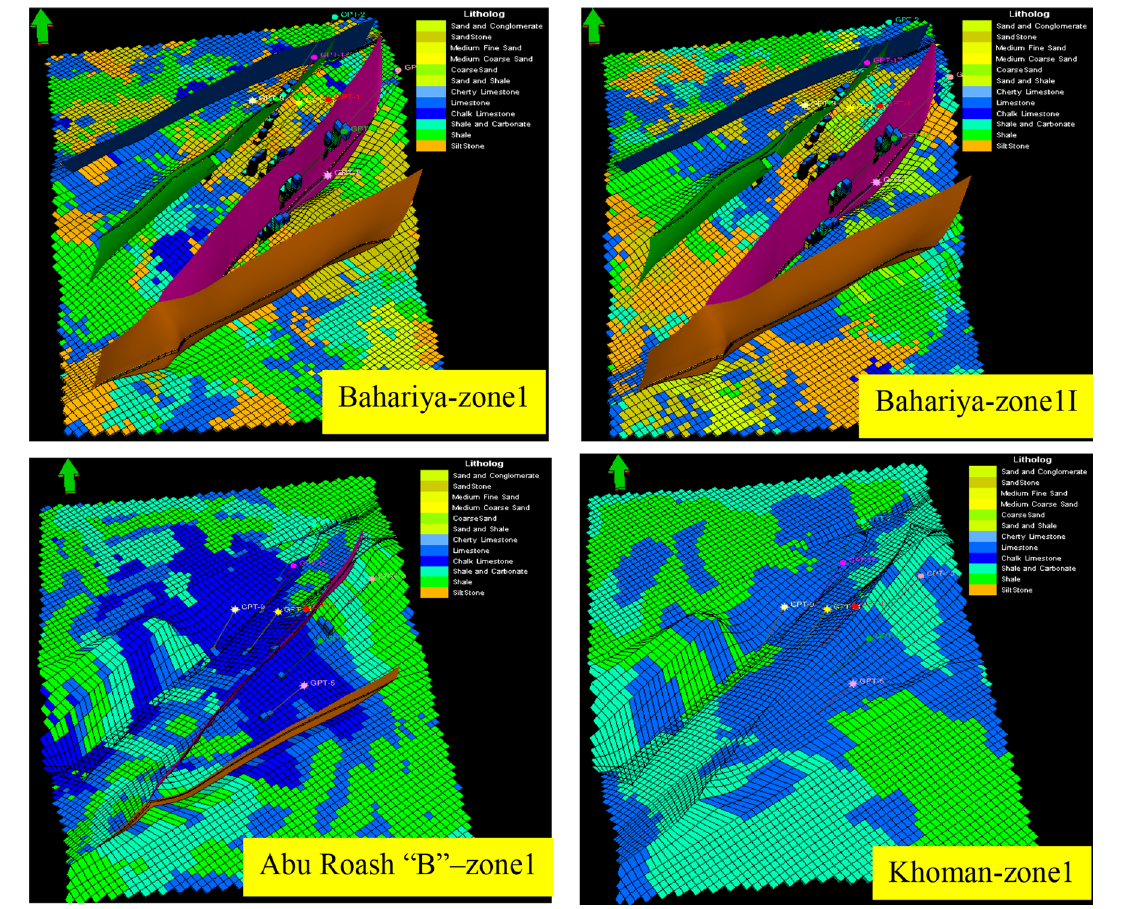
Fig. 14 Facies model example for the different pay